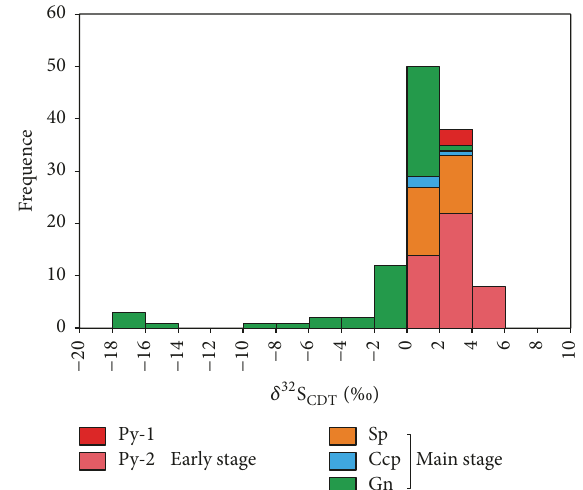
Figure 11: Sulfur isotope values of sulfide minerals from the Zhijiadi deposit. The values are expressed in per mil, related to the standard V-CDT (Vienna Canyon Diablo Troilite). Py-1, pyrite disseminated in quartz porphyry, Py-2, pyrite in ores; Sp, sphalerite; Ccp, chalcopyrite; Gn,